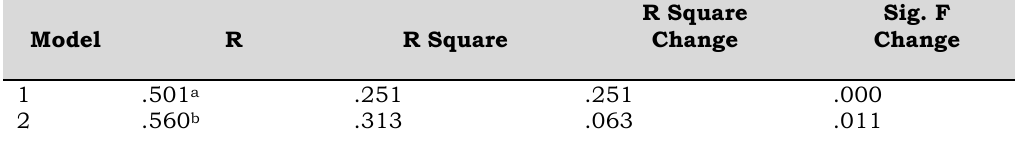
Table 7. Result of multiple regression test